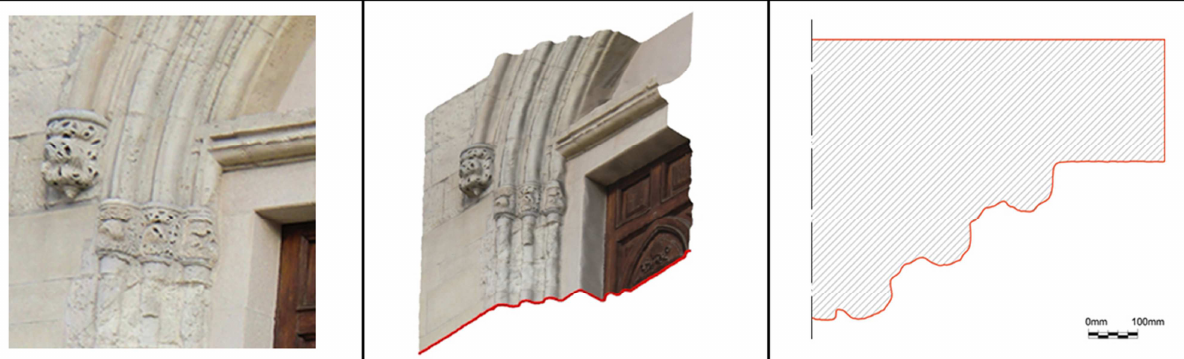
Figure 10. Portal of Sant’Ambrogio, Monserrato (Ca): photographic image; model 123D Catch; reconstruction of the flat section.